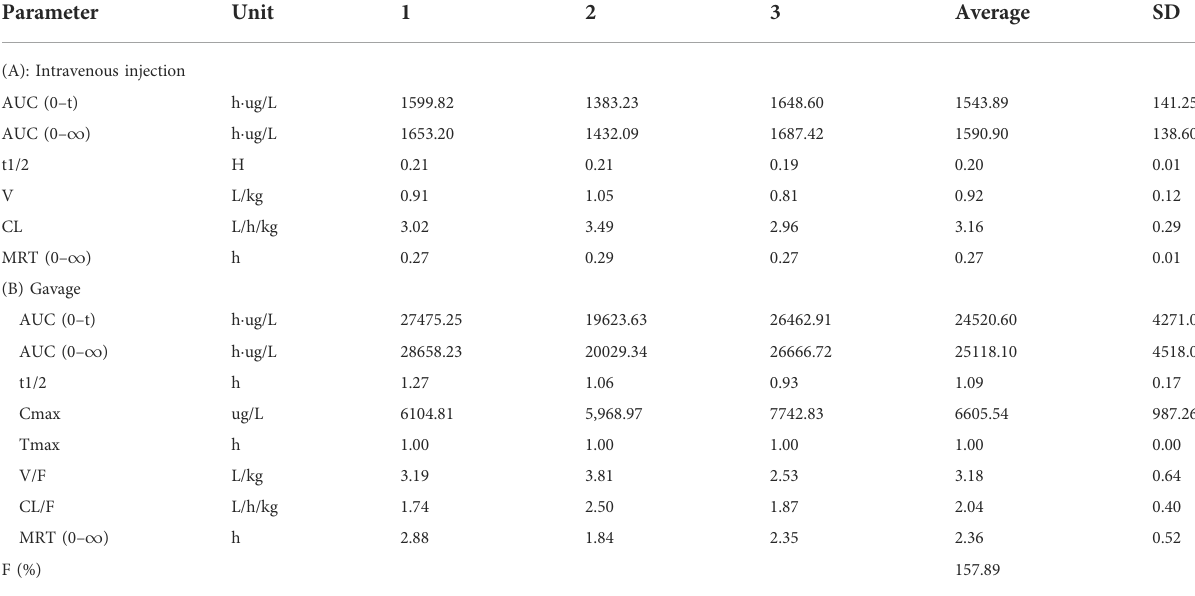
TABLE 5 Main pharmacokinetic parameters of allopurinol after intravenous injection and gavage in rats ( n = 3).